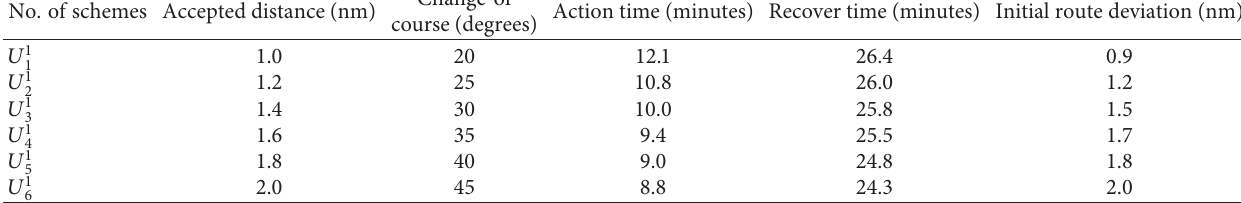
Table 2: Scenario I: collision avoidance schemes.